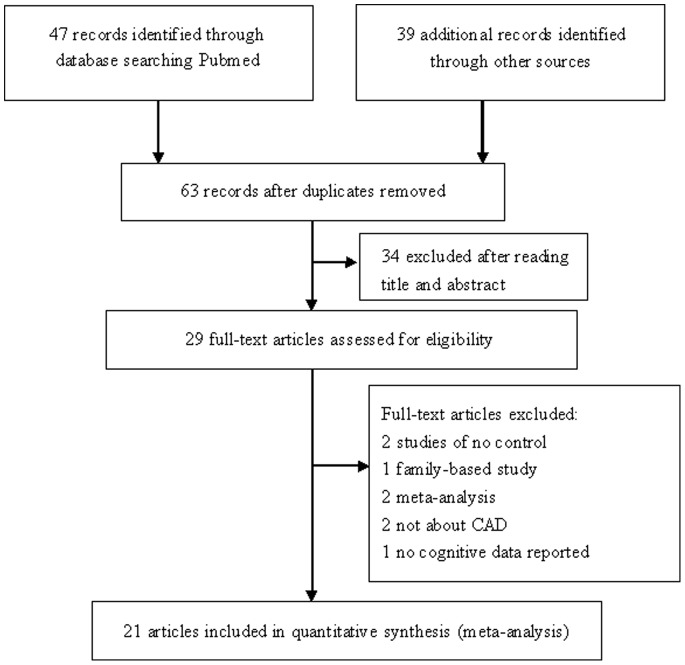
Flow chart of the literature search.CAD, coronary artery disease.